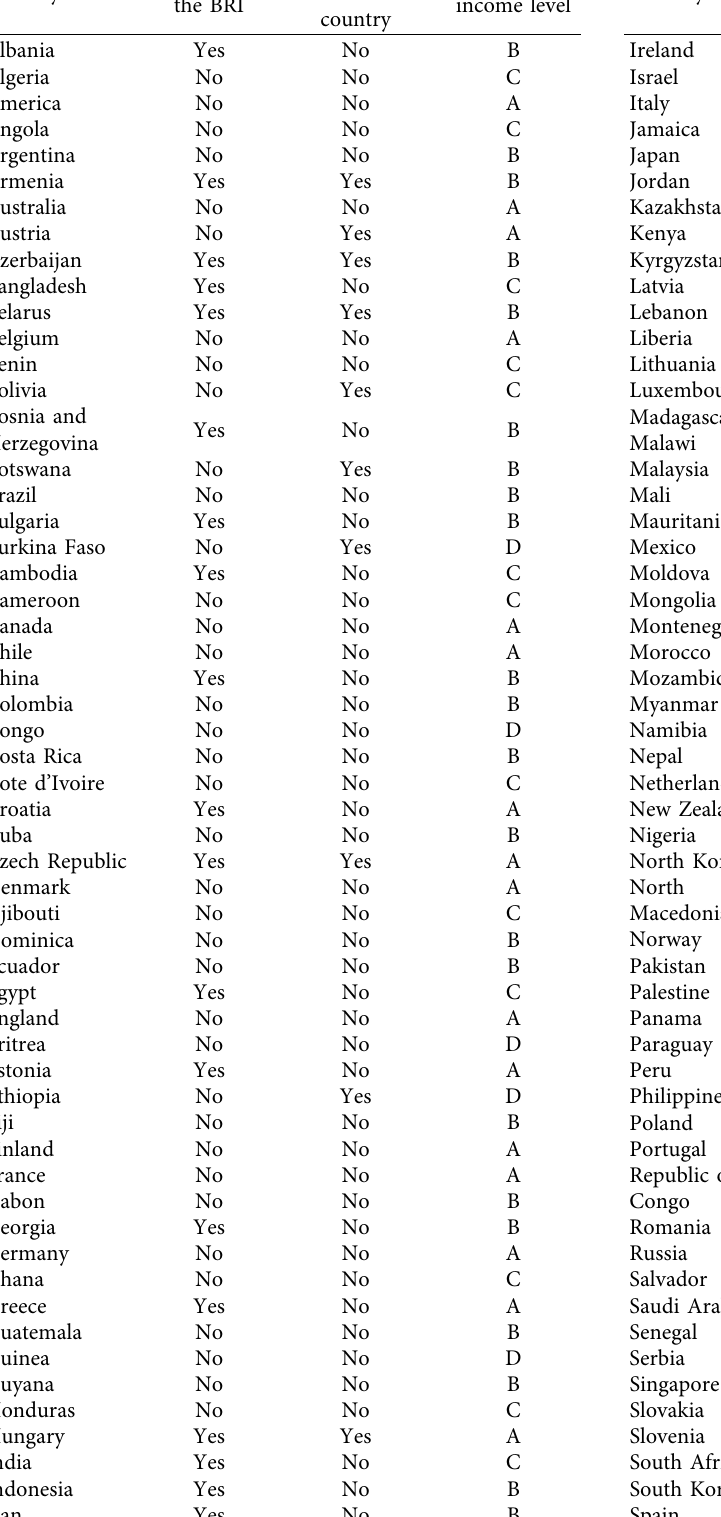
Table 1: List of countries and classification.